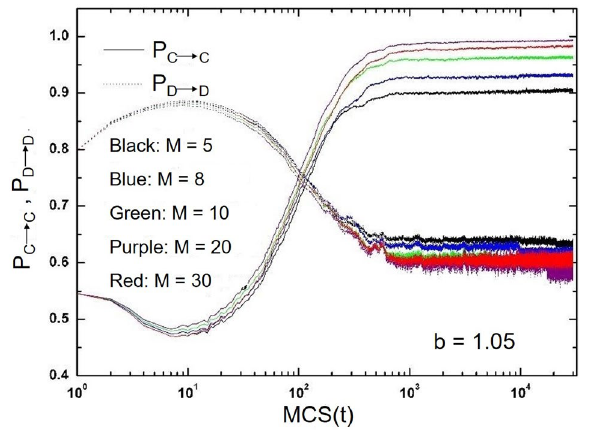
Figure 8. When β = 0.5 , the probability change of different strategies to remain stable.